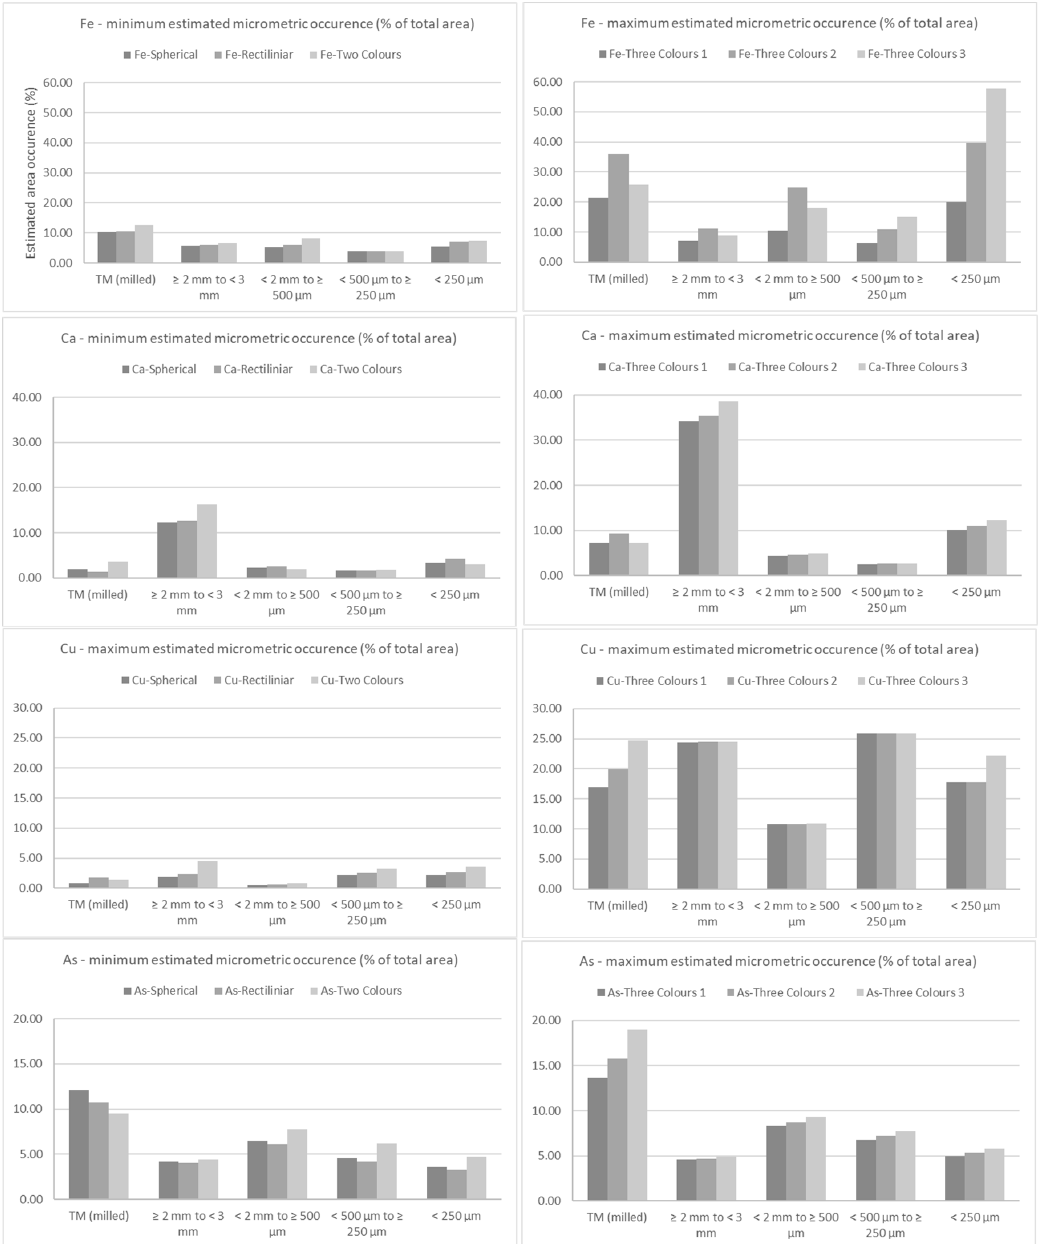
Figure 7. Minimum and maximum elemental occurrence in µ-XRF 2D map (percentage of area %) for Fe, Ca, Cu, and As.